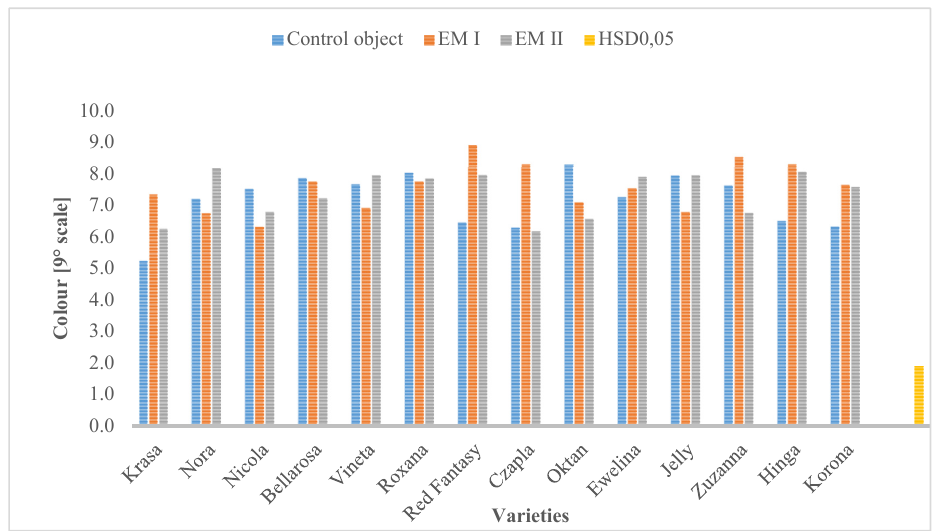
Figure 3. Influence of EM exposure and meteorological conditions in the research years on the color of PC. The cultivars ‘Krasa’, ‘Red Fantasy’, ‘Czapla’, ‘Zuzanna’, and ‘Hinga’ reacted with a significant improvement in the color of PC to the shorter EM exposure, compared to the control object. Among the examined cultivars, only ‘Oktan’ showed a negative reaction to a longer exposure of EMs, compared to the control object (Figure